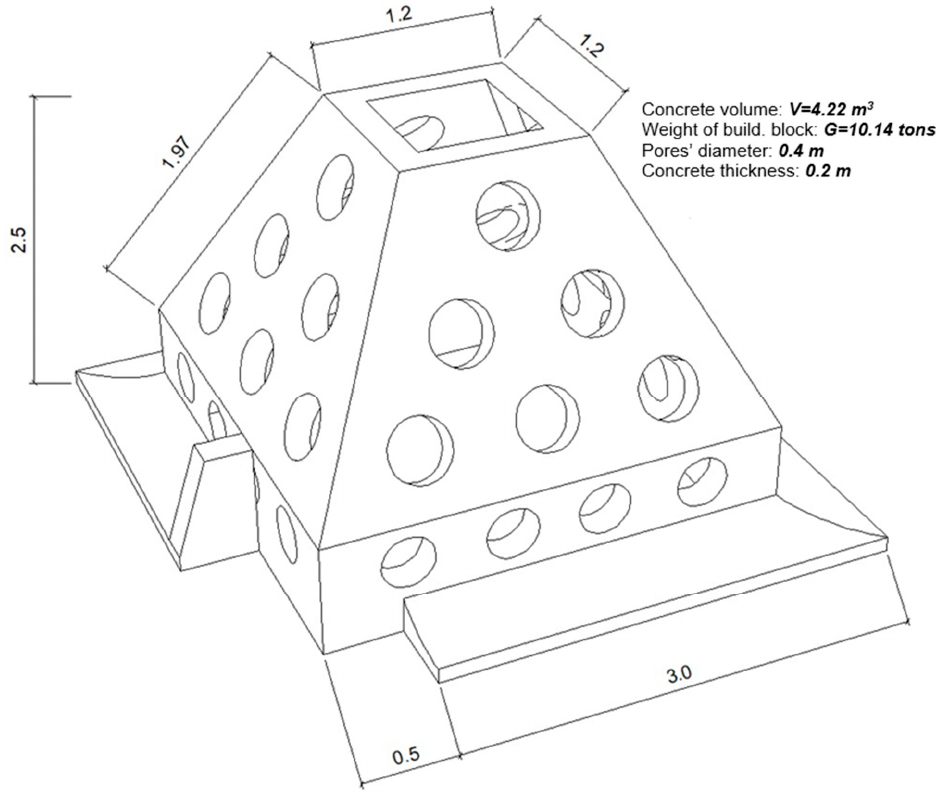
Figure 4. Dimensions of a PTPBW block.